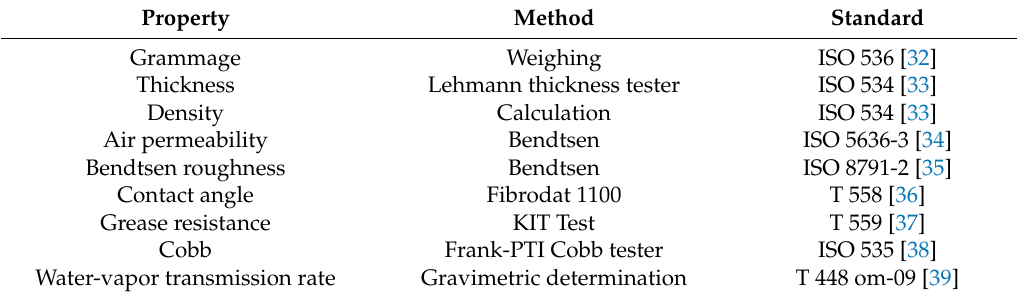
Table 2. Paper properties and standard methods used for the testing of uncoated and coated